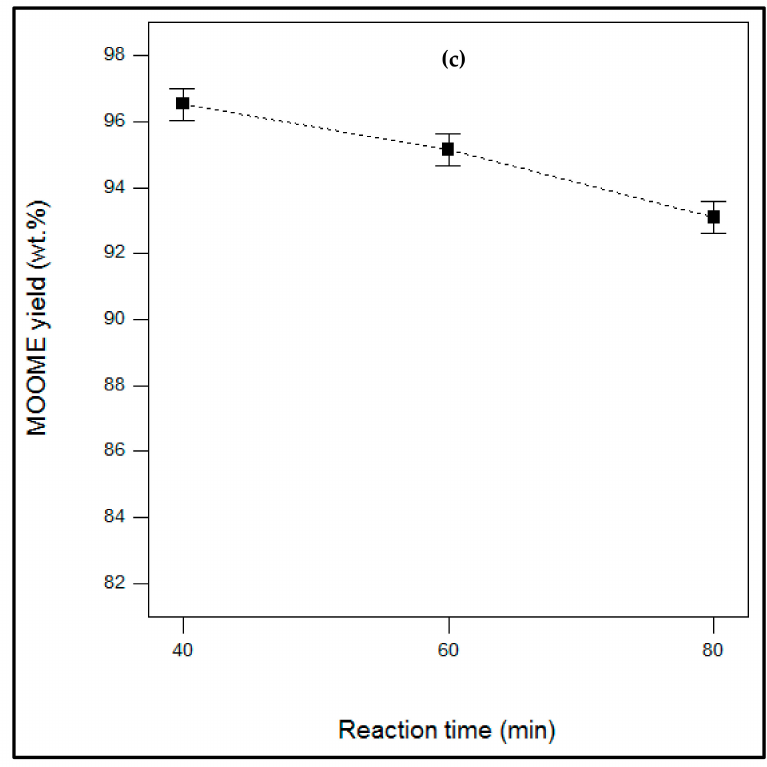
Figure 6. Plots of parametric e ff ect on MOOME yield ( a ) MeOH:MOO molar ratio, ( b ) CPP loading and ( c ) reaction